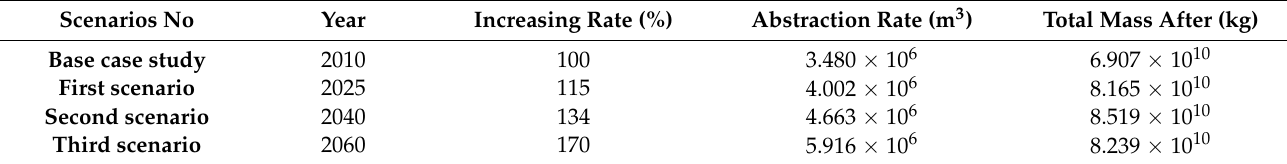
Table 3. Abstraction rates and total mass for different